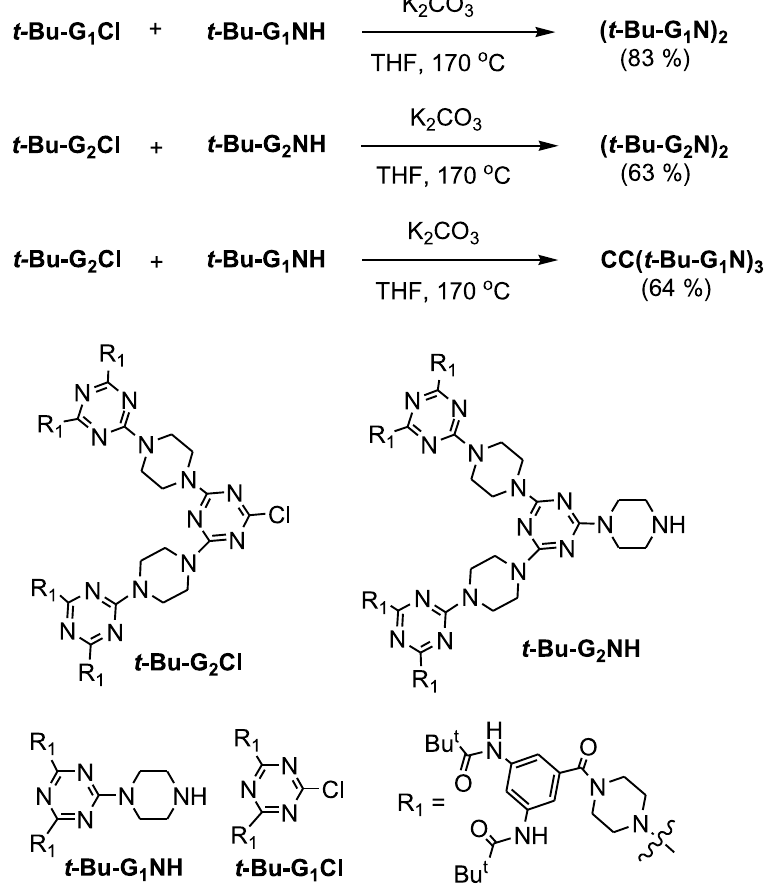
Figure 2. Preparation of dendrimers ( t - Bu - G 2 N ) 2 , ( t - Bu - G 1 N ) 2 and CC ( t - Bu - G 1 N ) 3